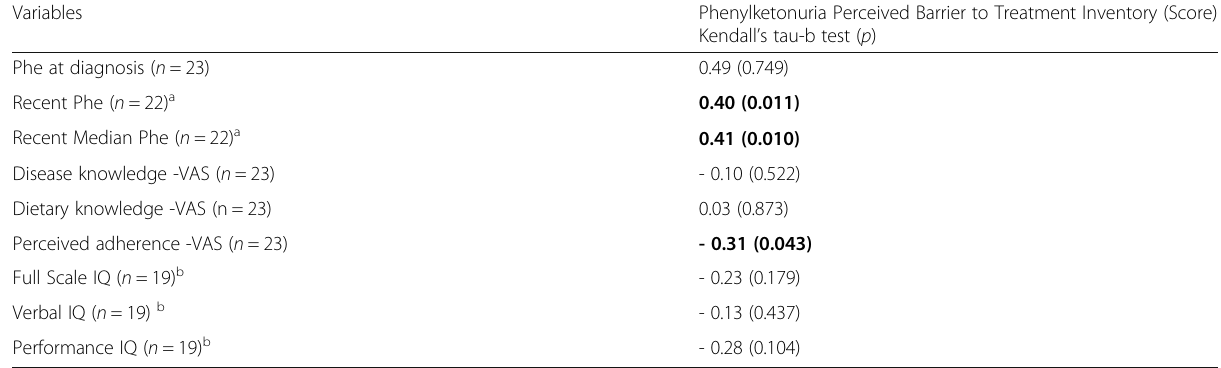
Table 7 Evidences that supports construct validity